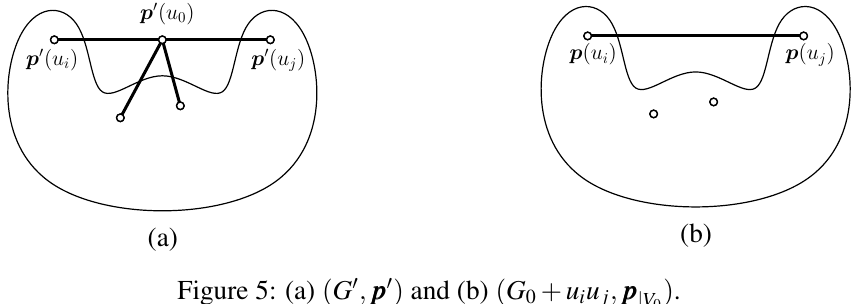
Figure 5: (a) ( G (cid:48) , ppp (cid:48) ) and (b) ( G 0 + u i u j , ppp